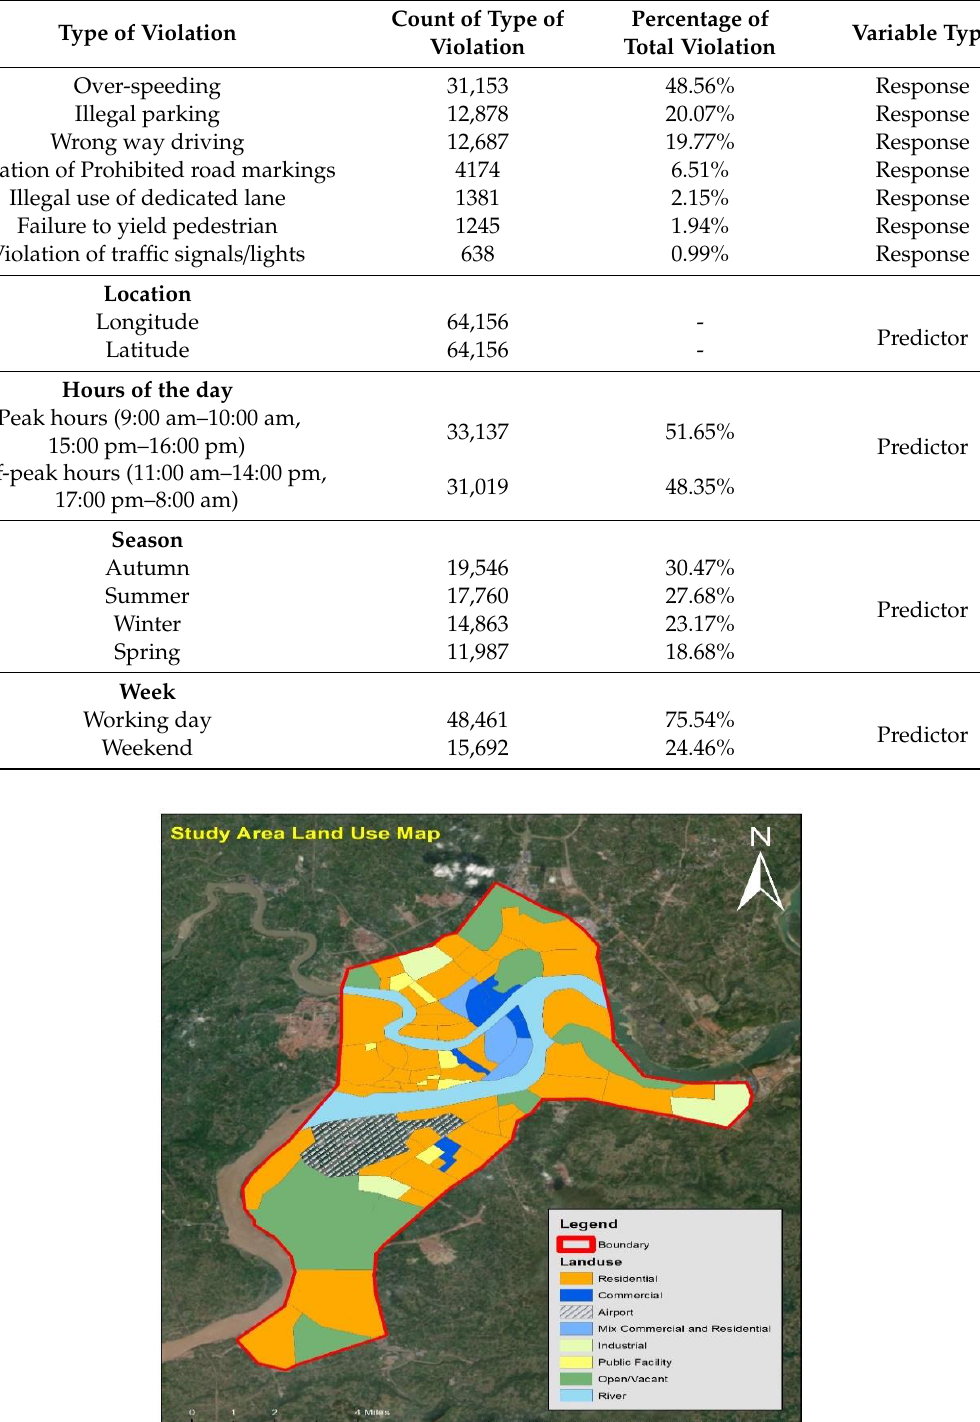
Table 1. Descriptive statistics of the violation samples ( N = 64,156).